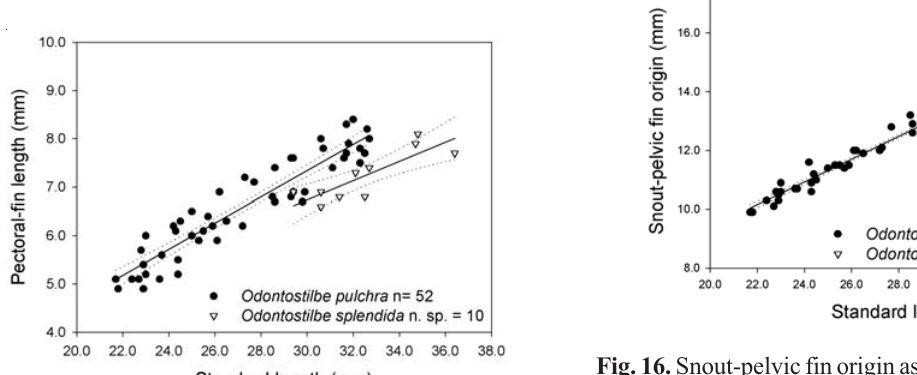
Fig. 16. Snout-pelvic fin origin as a function of standard length for males of Odontostilbe pulchra , against O. splendida .